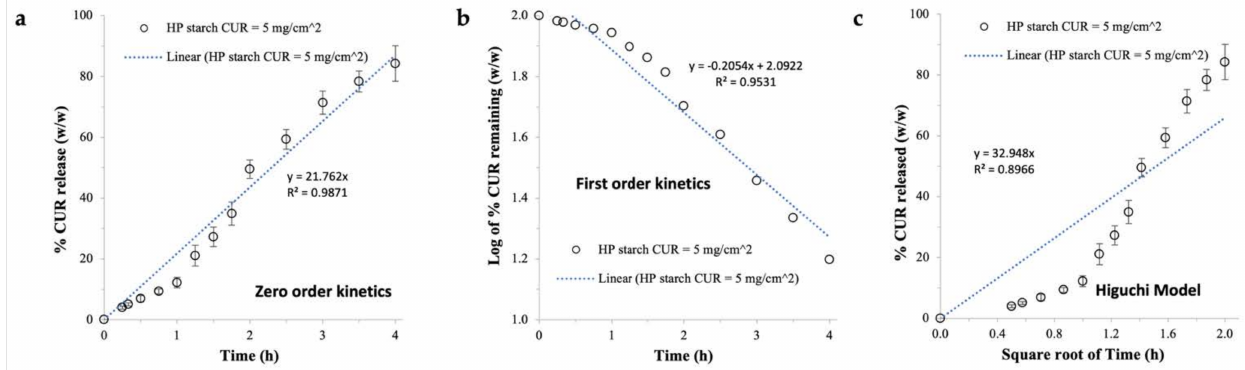
Figure A1. Dissolution kinetics modelling of the CUR release from HP starch film prepared at 5 mg/cm 2 ( a ) zero order kinetics, ( b ) first order kinetics, and ( c ) Higuchi model.